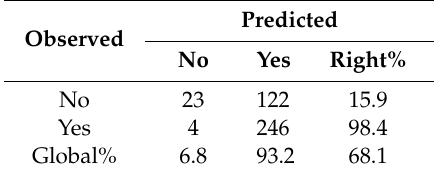
Table 5. Classification success for using Facebook.